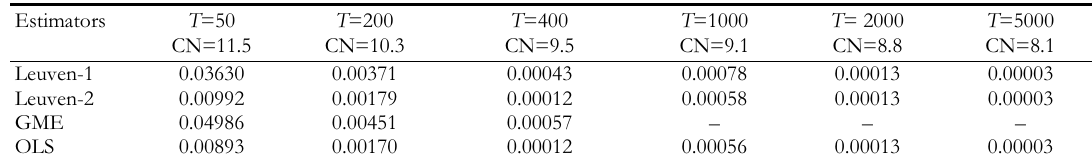
Monte Carlo experiment N. 1: model without intercept. Asymptotic unbiasedness of rival estimators. 100